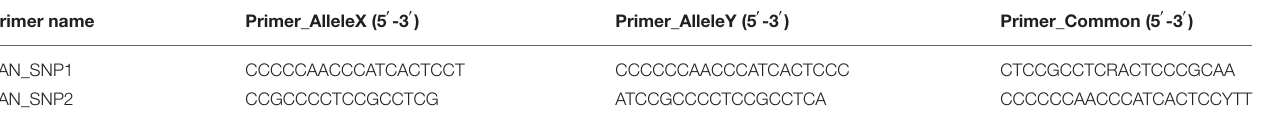
TABLE 2 | Primer sequences for KASP assay in this